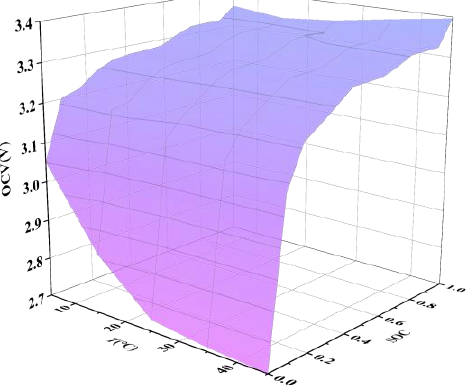
Figure 7. Relationship between OCV, SOC, and temperature.